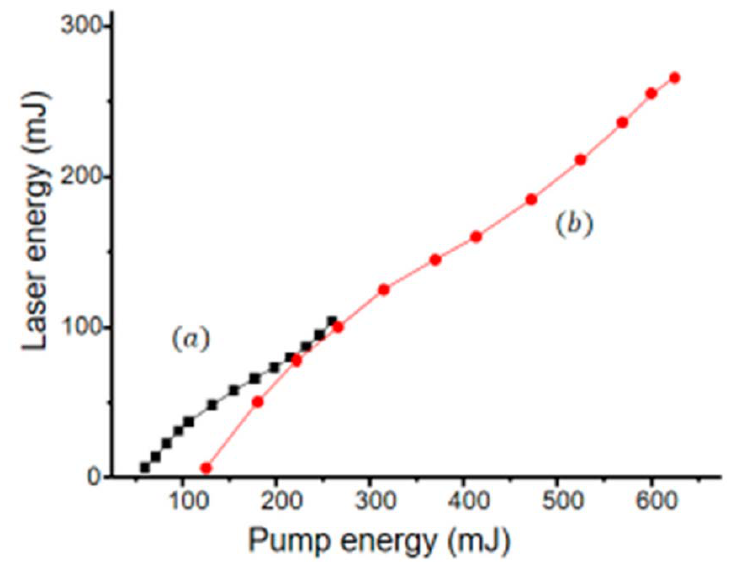
Figure 7. Dependence of E on E PUMP : ( a )—pump spot 3.4 × 3.4 mm, L = 7.5 mm; ( b )—pump spot 5.6 × 5.6 mm, L = 7.2 mm. Reprinted with permission from ref. [17]. Copyright 2019 © The Optical Society.